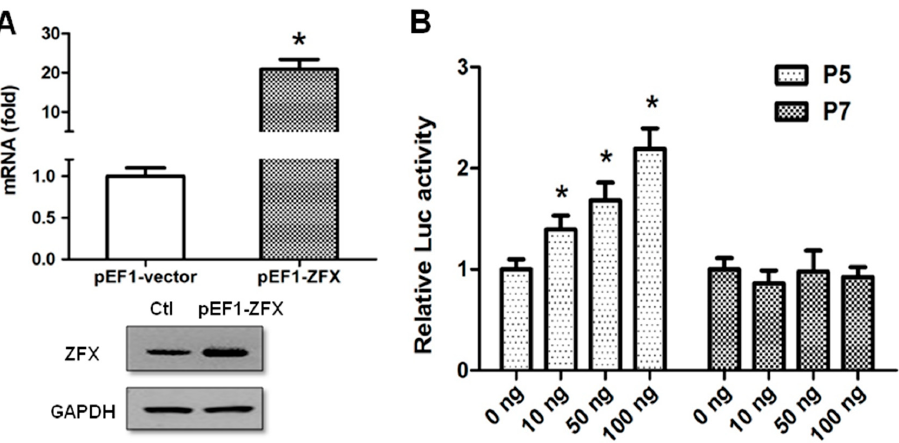
Figure 3. ZFX transactivates human SET transcript 2 promoter. ( A ) HeLa cells were transfected with 100 ng of pEF1-ZFX or pEF1-vector (control). At 48 h post-transfection, total RNA and proteins were isolated and ZFX expression was determined. Top panel: Results of real-time PCR showing a dramatic increase of ZFX RNA mRNA following ZFX overexpression. Bottom panel: Results of Western blotting showing an increased ZFX protein expression. GAPDH protein expression was determined and the results indicated equal protein loading; ( B ) Dose-dependent effect of ZFX on SET promoter activity. HeLa cells were co-transfected with increasing amounts of pEF1-ZFX (0–100 ng, pEF1-vector was used as a “stuffer” to keep a constant DNA amount) and 100 ng of P5 or P7 reporter plasmid. Luciferase activity was measured at 24 h post-transfection. Quantitative data is presented as means ± SD from three independent experiments. (*, p < 0.05).